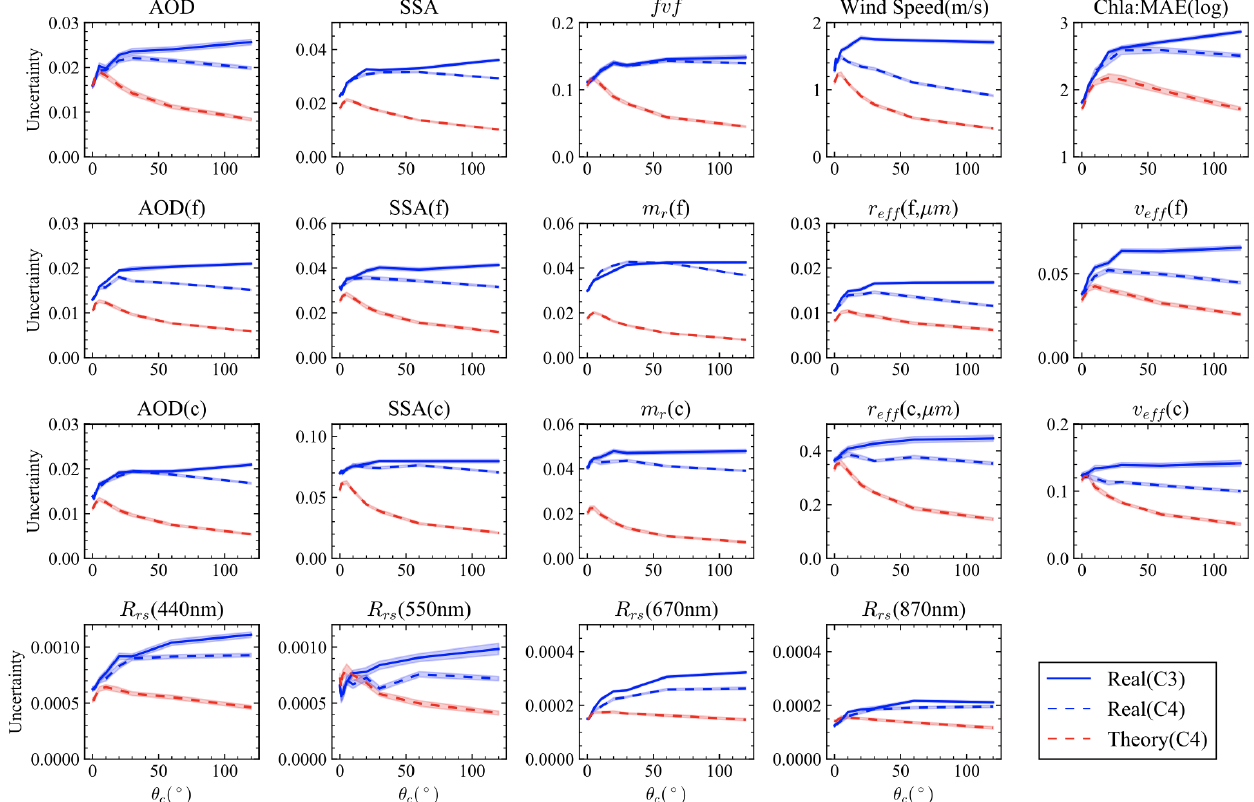
Figure 6. Retrieval uncertainties averaged for the AOD within [ 0 . 01 , 0 . 5 ] based on the MCEP method for synthetic AirHARP measurements. Ten sets of random samples are conducted, with the mean values shown in the plot and standard deviation indicated by the width of the shaded lines. The blue lines indicate the real uncertainty for Scenario C3 and Scenario C4 (Table 3), and the red line indicates the theoretical uncertainty for Scenario